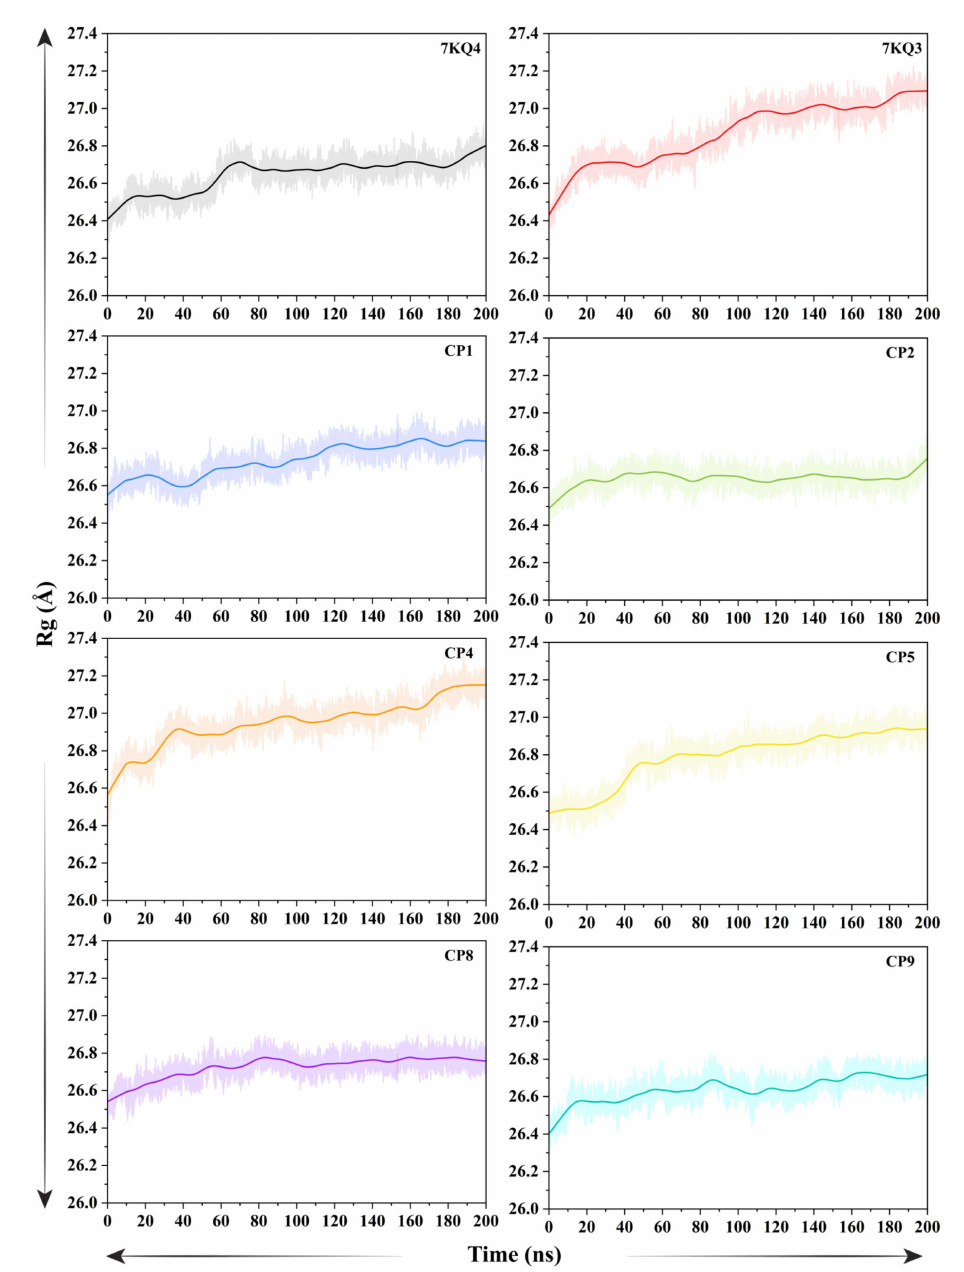
Figure 5. The radius of gyration (Rg) analysis plots of free stat (7KQ4), substrate-bound (7KQ3), and selected ligands-bound